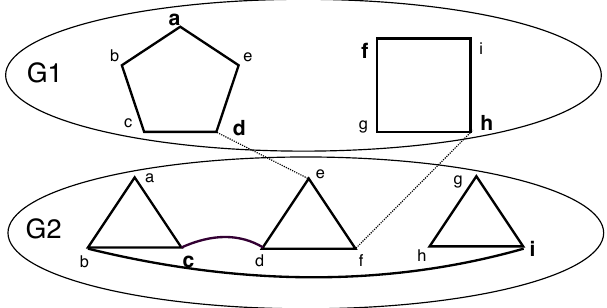
Figure 5. MDS: The vertices of a minimum dominating set are { a , d , f , h } from G 1 and { c , i } from G 2 . The cardinality of any MDS of G is 6. The vertices of MDS are shown in larger bold font.